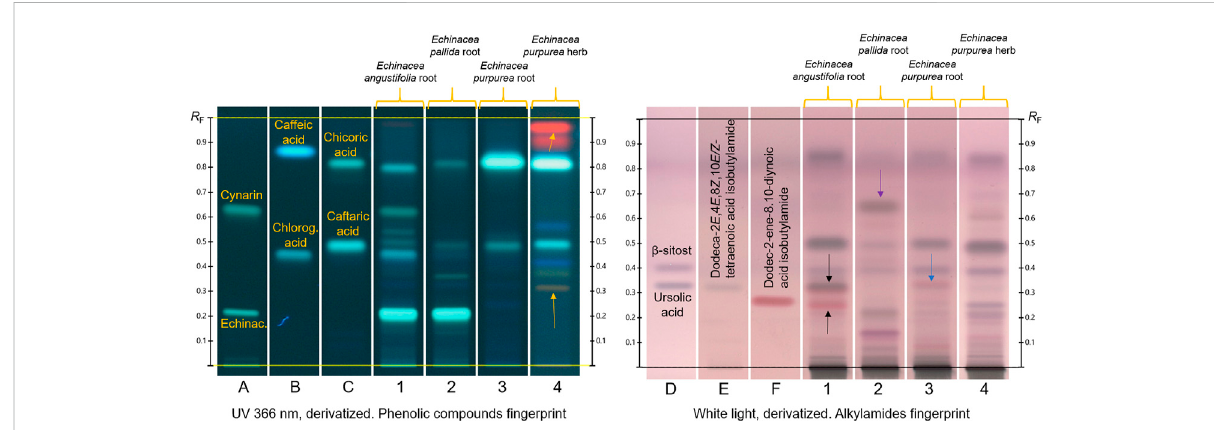
FIGURE 3 Characteristic HPLTC fi ngerprints of standards (tracks A – E ) and cone fl ower herbal drugs (tracks one – 4): phenolic compounds (left image); alkylamides (after second heating step, right image). Yellow arrows: zones characteristic of Echinacea purpurea herb; black arrows: zones due to alkylamides of E. angustifolia root; purple arrow: zones characteristic of E. pallida root; blue arrow: zone due to alkylamides in E. purpurea